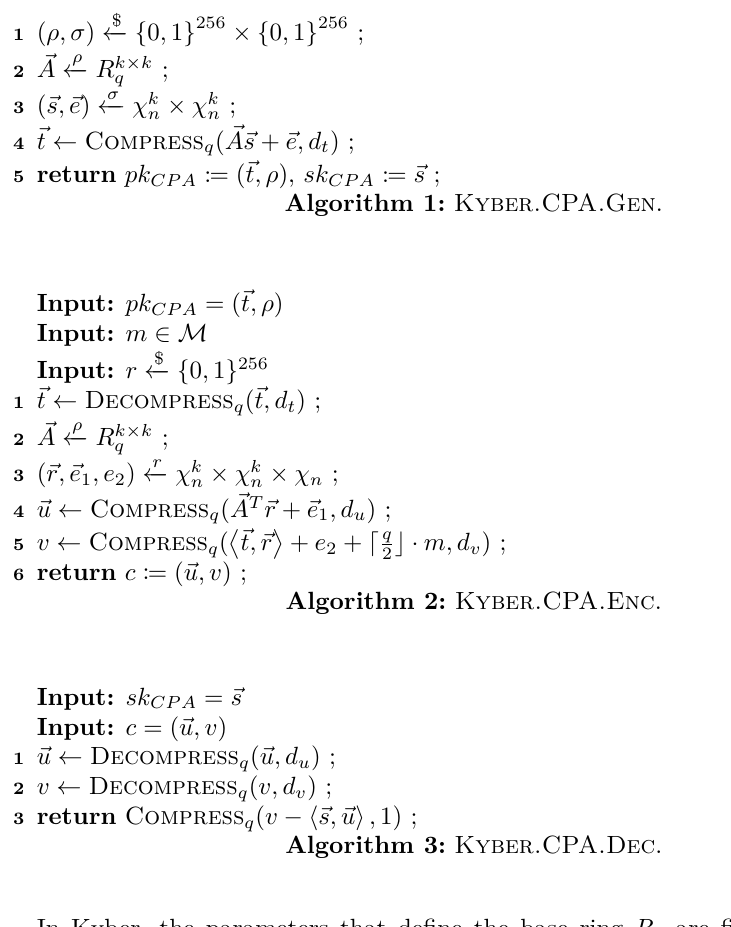
Algorithm 1: Kyber.CPA.Gen .